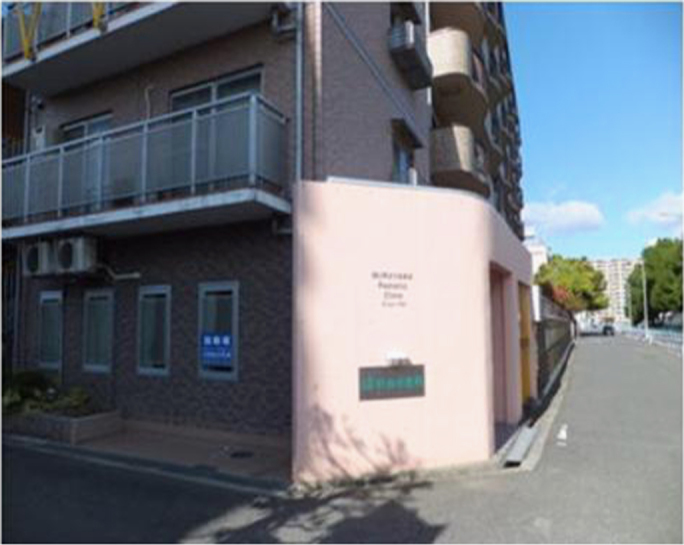
Murayama Pediatrics, Since 1994, Osaka, Japan. This is our Murayama Pediatric Clinic. In this clinic all nasal eosinophil data were gathered.